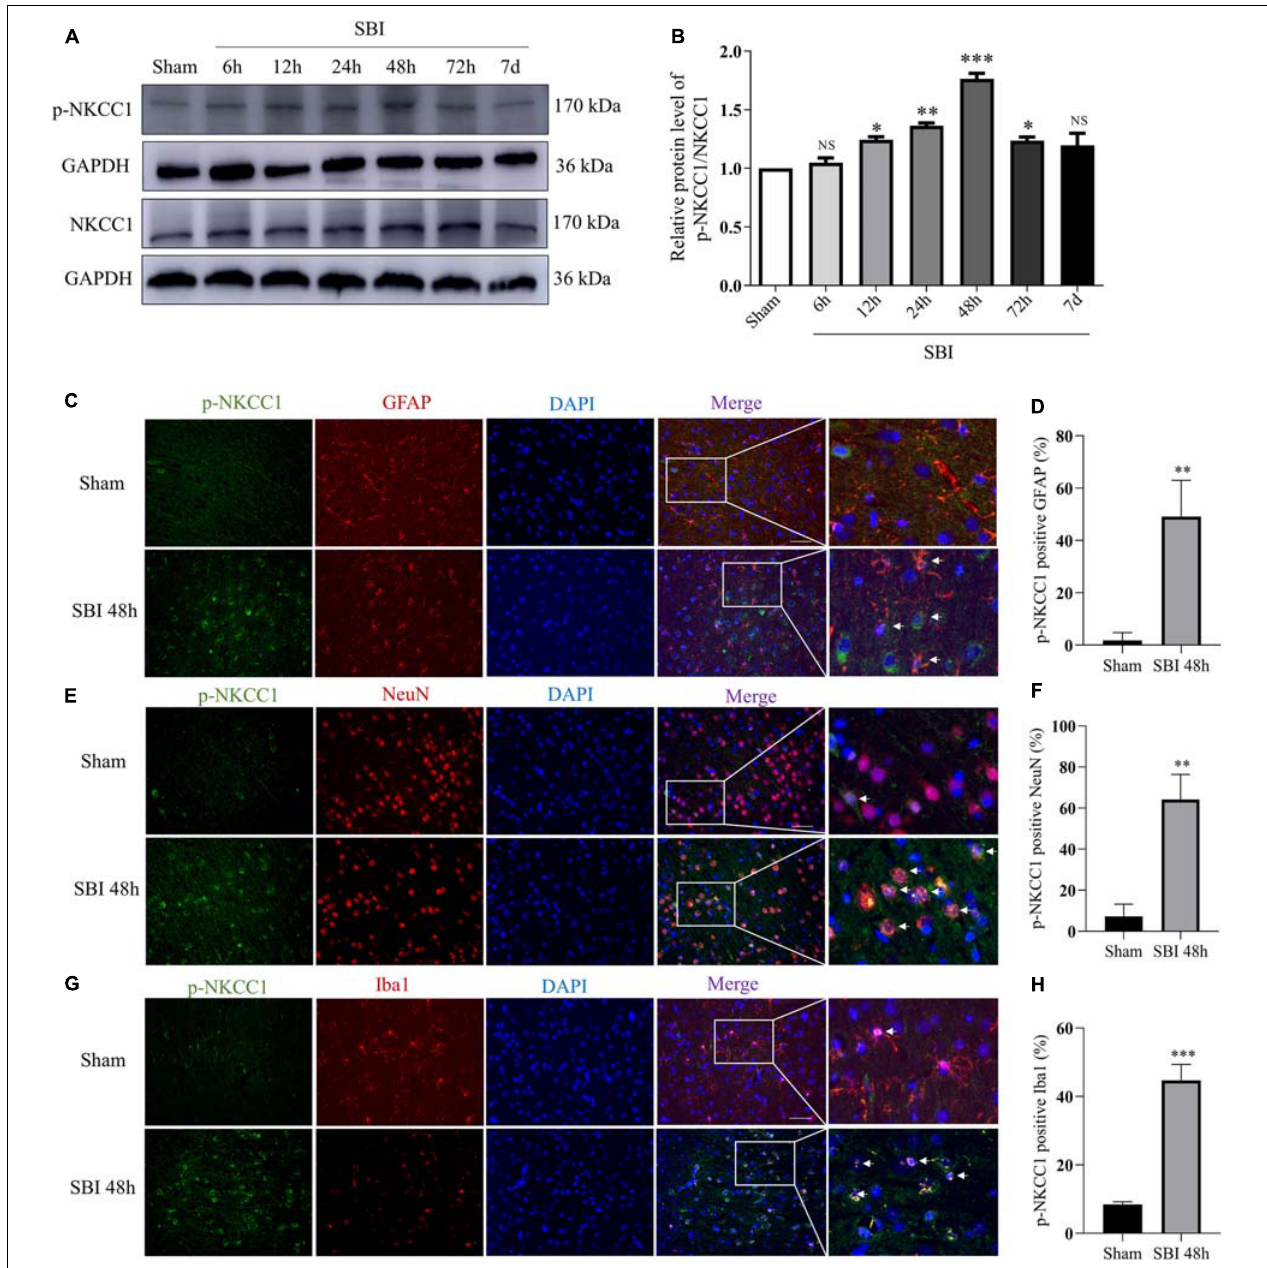
FIGURE 2 | Expressions and localization of NKCC1, p-NKCC1 in lesions of the peripheral cortex after SBI. NKCC1/p-NKCC1 protein expression levels at 6 h, 12 h, 24 h, 48 h, 72 h, and 7 days in the SBI and sham groups were assessed by western blotting (A,B) . The relative densities of each protein were normalized to the sham group. ImageJ software was employed for quantification of protein expression levels, with the mean value of the sham group normalized to 1. Statistical analysis was conducted using a K–W one-way ANOVA, followed by the Student–Newman–Keuls post hoc test. In the sham group and 48 h after SBI, the expression of green-labeled p-NKCC1 and red-labeled GFAP (C,D) , NeuN (E,F) , Iba1 (G,H) were assessed by double IF. The nuclei were stained with DAPI (blue) fluorescence. Arrows show p-NKCC1 co-localization with astrocytes, microglial cells, and neurons. Scale bar = 50 µ m. Statistical analyses were conducted using Student’s t -tests, n = 4 for each group. * P < 0.05, ** P < 0.01, *** P < 0.001, ns P > 0.05, compared to the sham